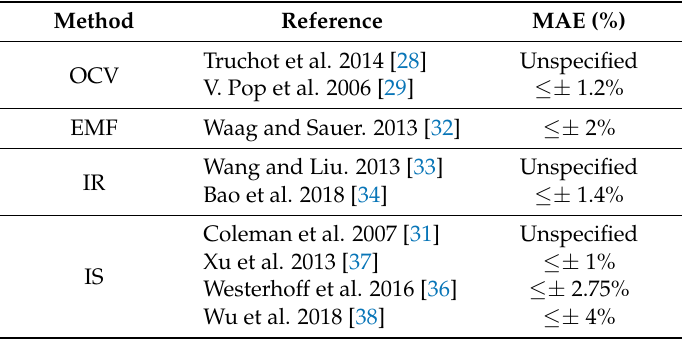
Table 3. MAE of the direct SOC estimation